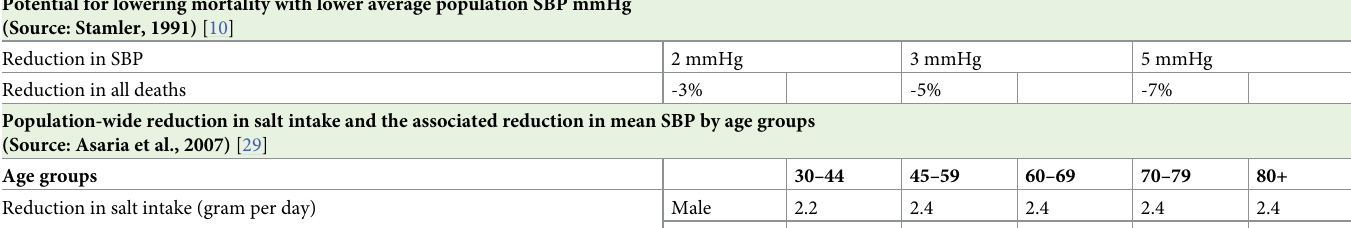
The associated reduction in mean systolic blood pressure by 2015 (mm Hg) Projections for 2030 (Scenario II) deaths from all-causes (% Reduction in Death ACik ) Age groups Percent reduction in total death from